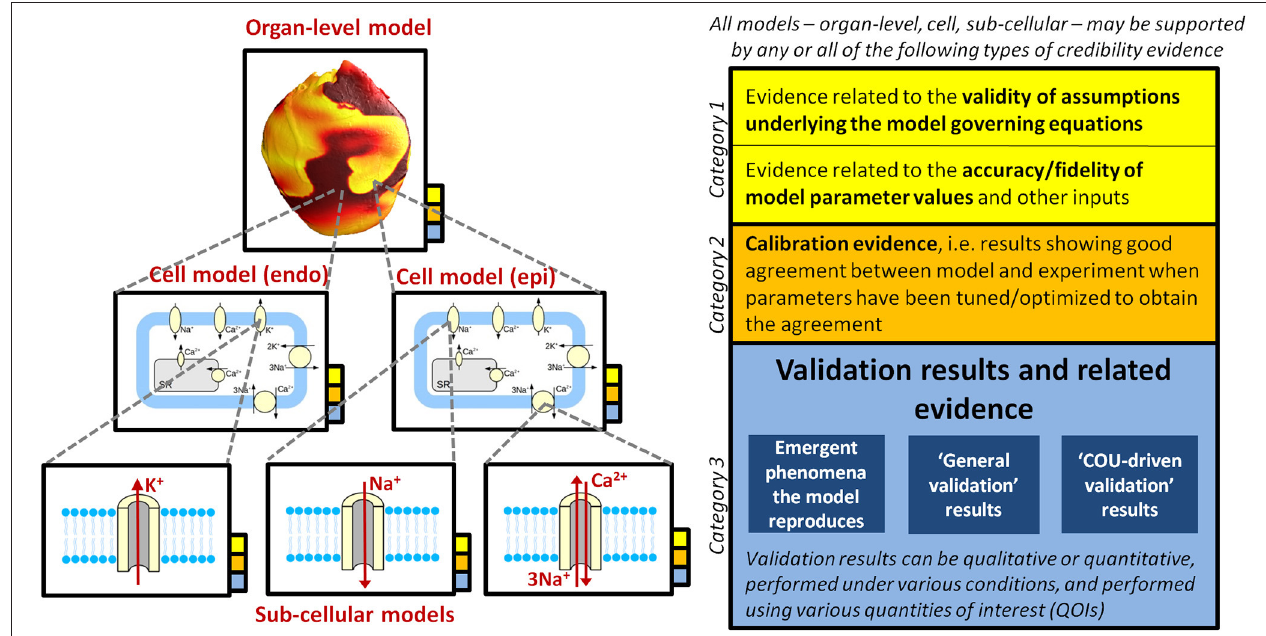
FIGURE 2 | Illustration of how a multiscale CEP model may be supported by multiple sources of credibility evidence (that is, evidence relevant when assessing the credibility of the model), taken from model evaluation at multiple scales. The overall model (i.e., organ-level model), the underlying cell models (here it is assumed that the organ-level model incorporates two different cell models, one for epicardial tissue, one for endocardial), and all underlying sub-cellular models may all be supported by the different types of evidence presented in the right of the figure. See section Why Trust a Computational Model? for full